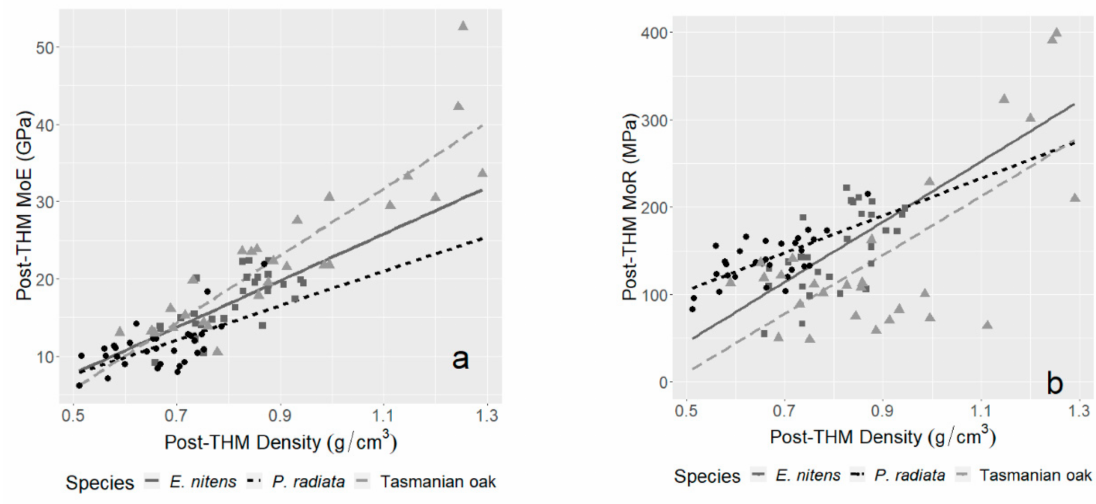
Figure 3. Correlation graphs between MoE ( a ), MoR ( b ), and density of the samples after THM treatment ( E. nitens in grey solid line and square dots, P. radiata in black dotted line and black dots, and Tasmanian oak in light grey dashed line and triangular